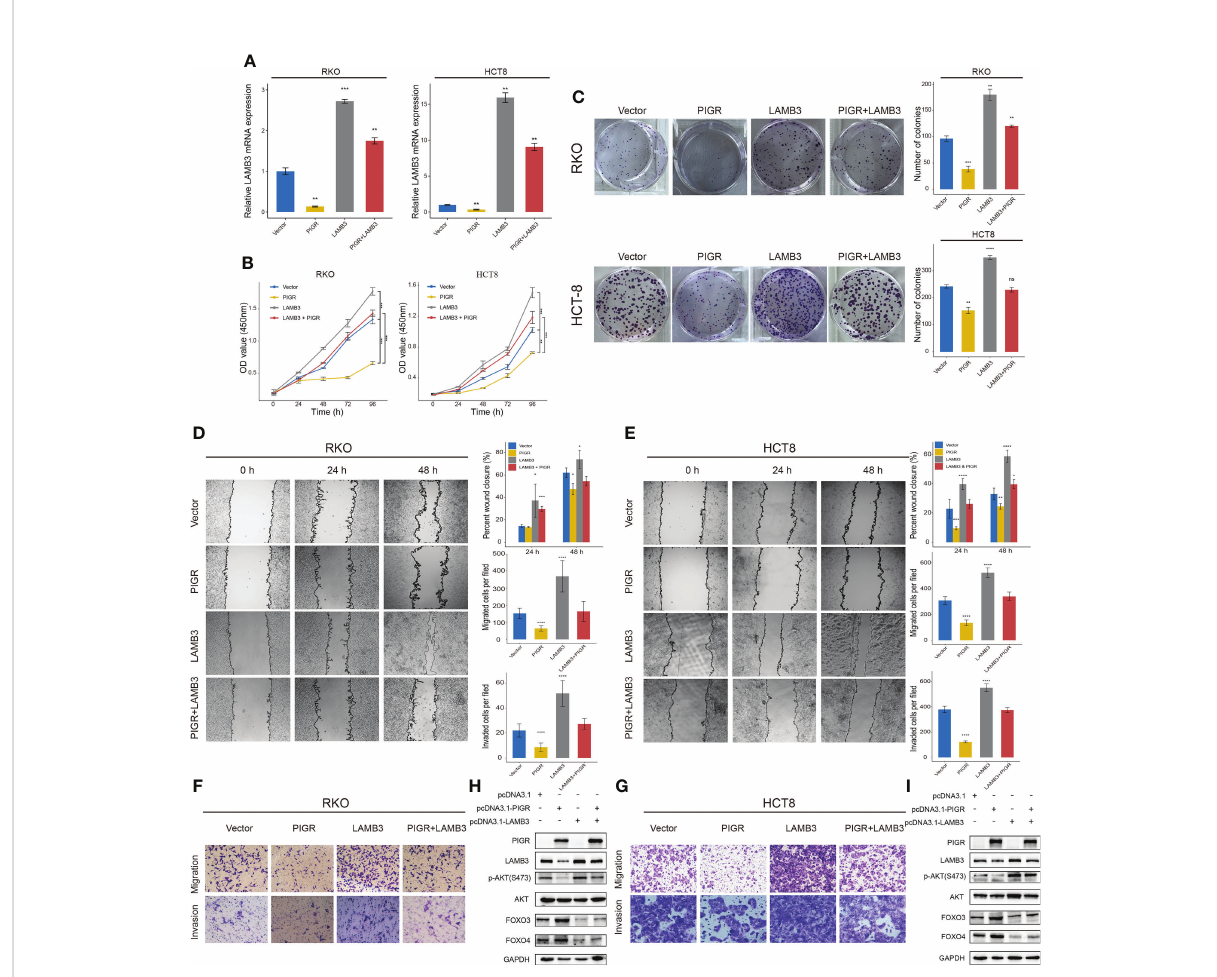
FIGURE 4 PIGR suppresses AKT-FOXO3/4 axis through LAMB3 (A) Relative LAMB3 mRNA expression of empty vector (Vector), PIGR-overexpressing (PIGR), LAMB3-overexpressing (LAMB3) and rescue experiment group (PIGR & LAMB3) in RKO and HCT-8 cells. Differences compared to Vector group (n = 3; one-way ANOVA, P adjusted by FDR). (B) Cell proliferation was detected by CCK-8 assay at 0, 24, 48, 72 and 96 hours in RKO andHCT-8 cells (n = 3; one-way ANOVA, P adjusted by FDR). (C) The colony formation assay of RKO and HCT-8 cells (n = 3; one-way ANOVA, P adjusted by FDR). (D-G) Wound healing, migration, and invasion assays were performed in RKO and HCT-8 cells (n = 3; one-way ANOVA, P adjusted by FDR). (H, I) Western blot showed altered protein levels of AKT-FOXO3/4 axis in empty vector, PIGR-overexpressing, LAMB3- overexpressing and rescue experiment group in RKO and HCT-8 cells. Differences compared to Vector group. Data are presented as the mean ± S.D. *P < 0.05; **P < 0.01; ***P < 0.001; ****P <